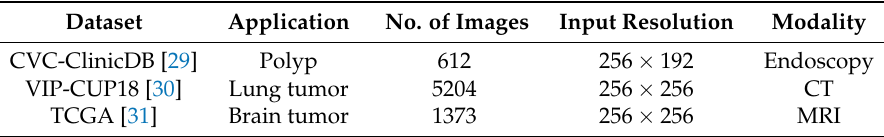
Figure 5. Example of images and ground truth images from three dataset. Table 1. Overview of the